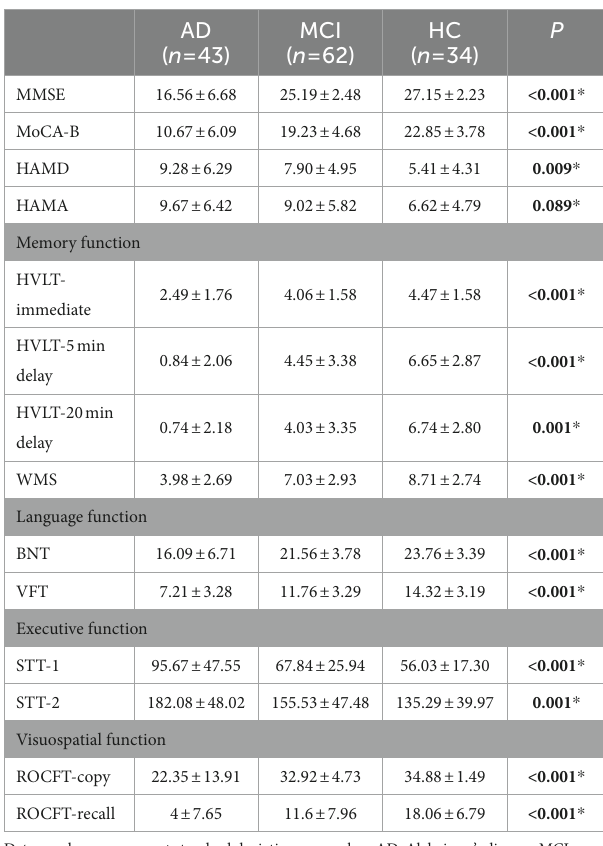
TABLE 1 Patient’s demographic characteristics. TABLE 2 Assessment of cognitive function in each